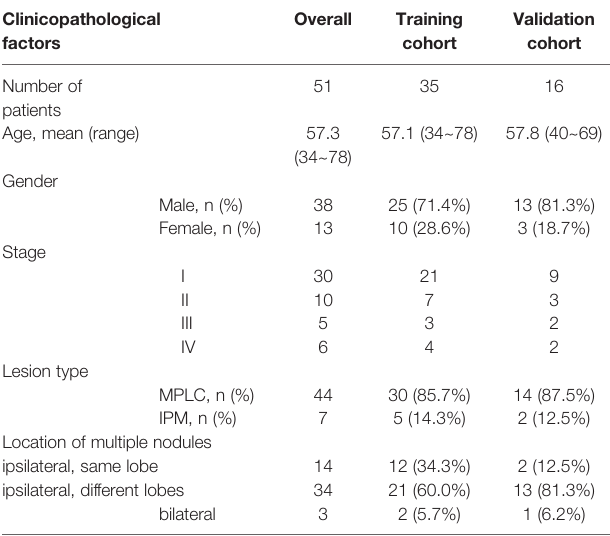
TABLE 1 | Clinicopathological information for lung cancer patients involved in this